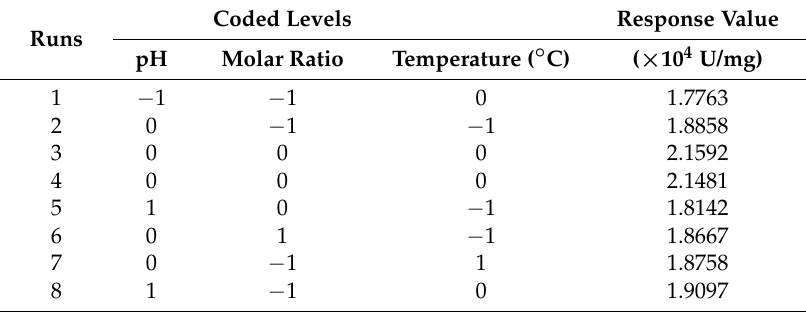
Table 1. Experimental design and results for the activity of Mal-mPEG5000-SPA.